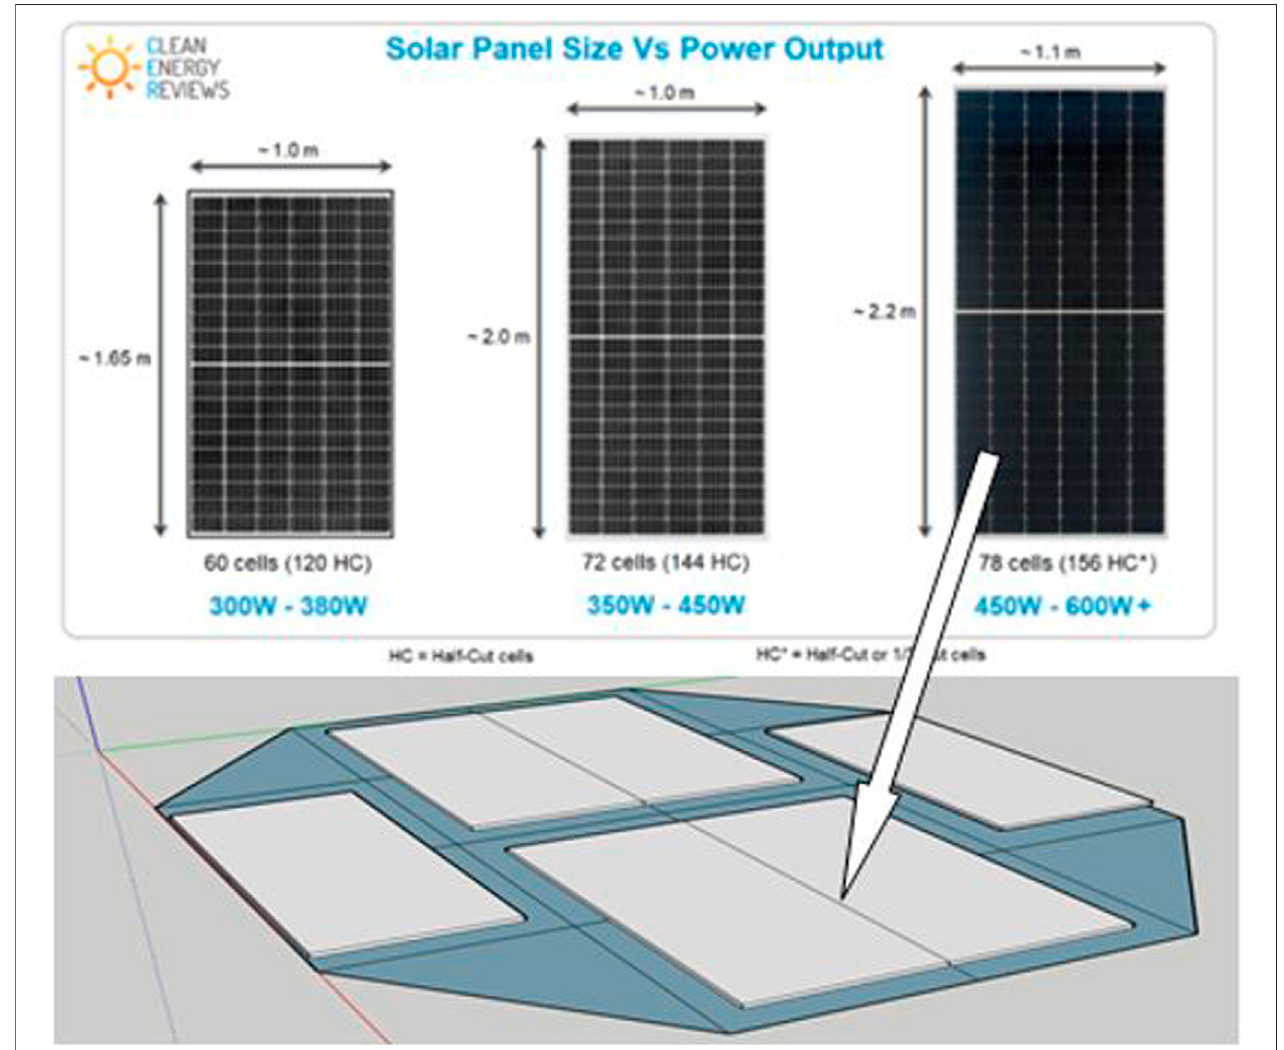
FIGURE 3 | Placement of PV panels on the